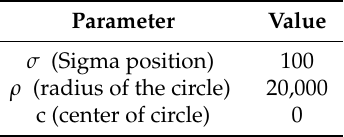
Table 2. Linear matrix inequalities (LMI) parameters used for controller